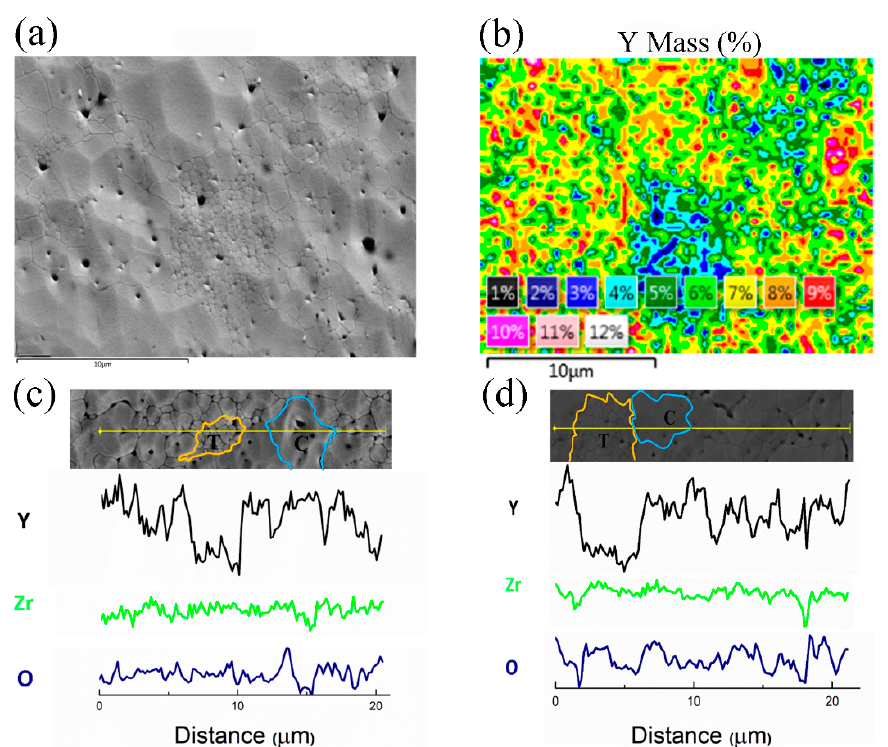
Figure 1. EDS mapping and a line graph of Y element on the surface of 8YSZ annealed at 1300 °C for 24 h. ( a ) SEM image ( b ) corresponding EDS Mapping, different color coding indicating the various weights of the Y element ( c ) and ( d ) EDS line scanning of another two different areas.